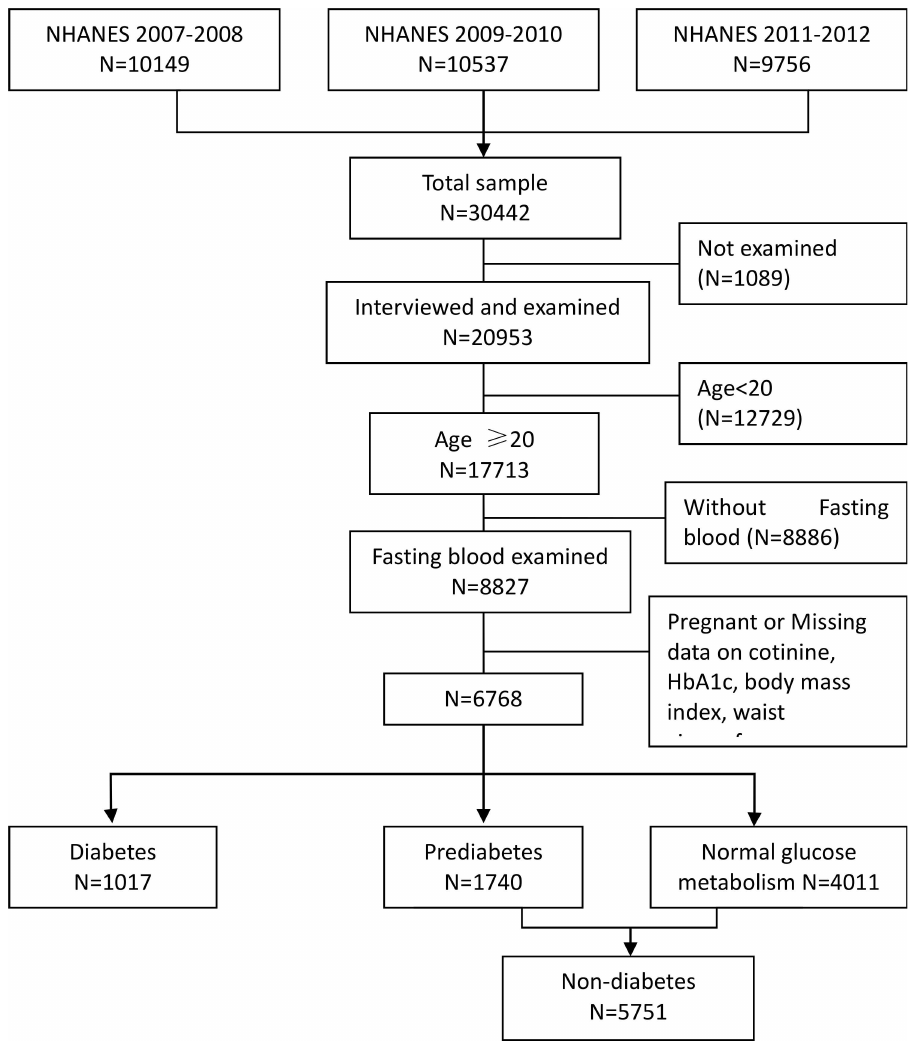
Fig 1. Flowchart depicting three successive waves (2007–2012) of continuous NHANES used for